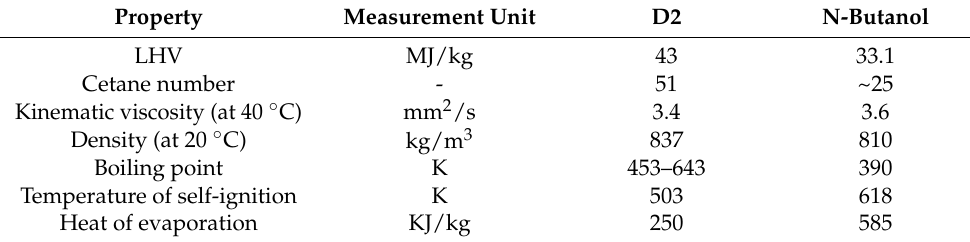
Table 1. ICE-relevant fuel properties [35,36].